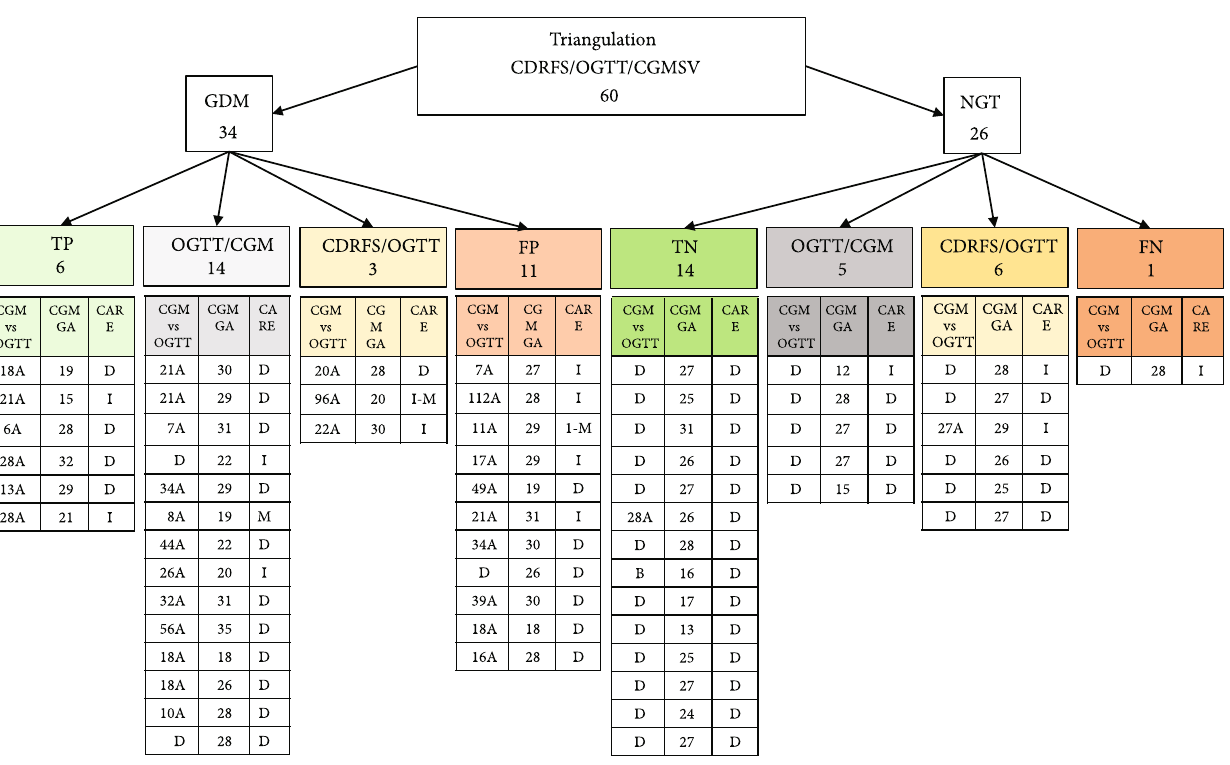
Figure 2: Results of CDRFS, OGTT results, and CGMSV